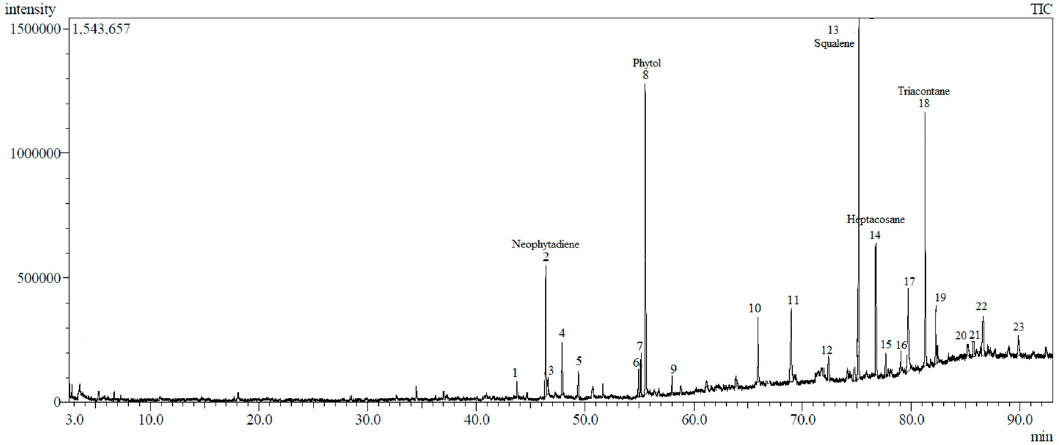
Figure 4. Ion chromatogram of DCM crude extract using GCMS.